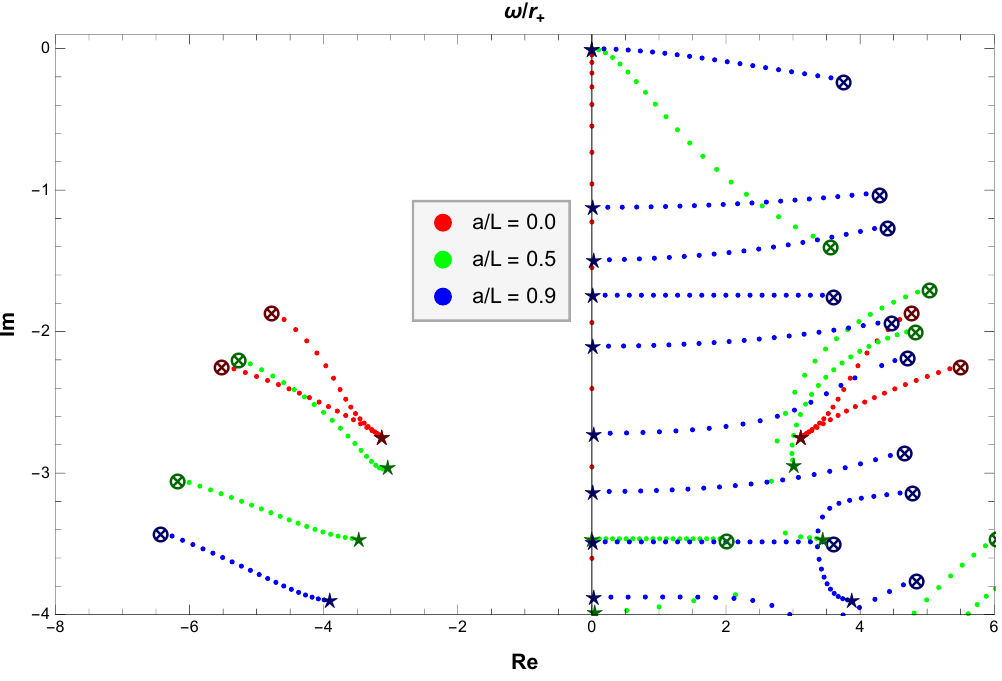
Figure 4 . Vector sector QNMs. The QNMs of h 3+ and h t + (and h ++ ) at K = J + 1 for r + = 100 at J = 0 ; 5 ; 10 ; 20 ; : : : ; 100, where the star indicates the value at J = 0, the circled cross indicates J = 100. This is case